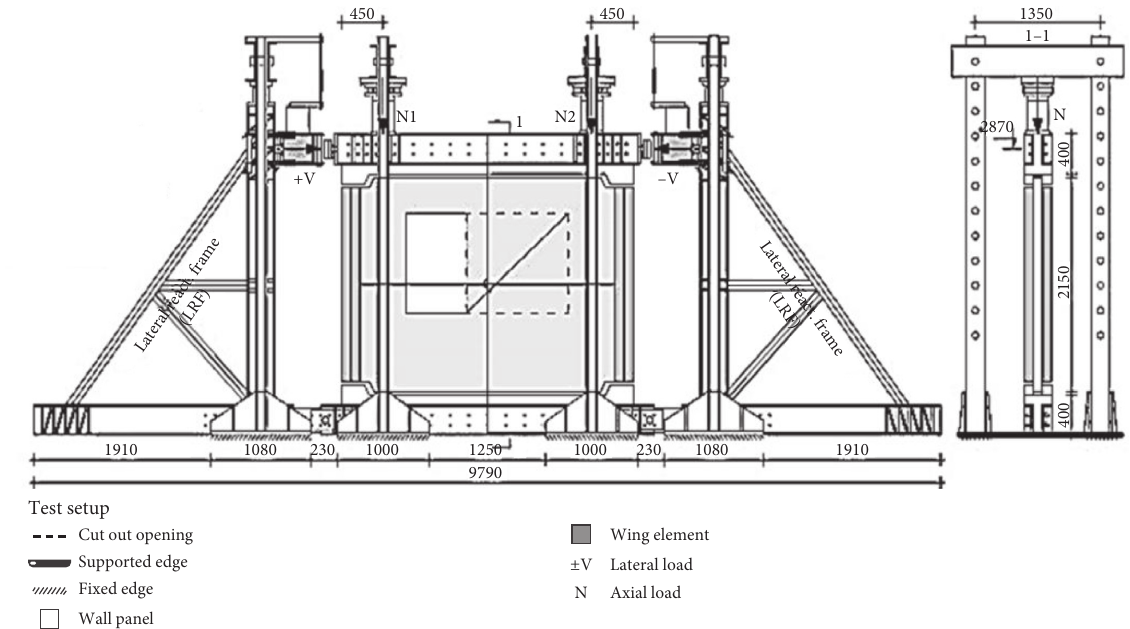
Figure 2: Experiment setup